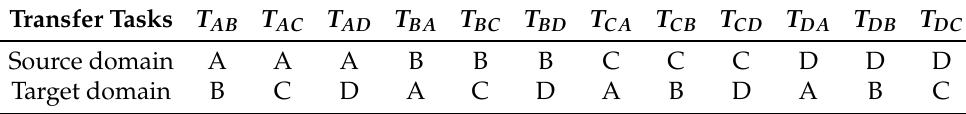
Table 2. Description of the transfer diagnosis tasks for the DDS